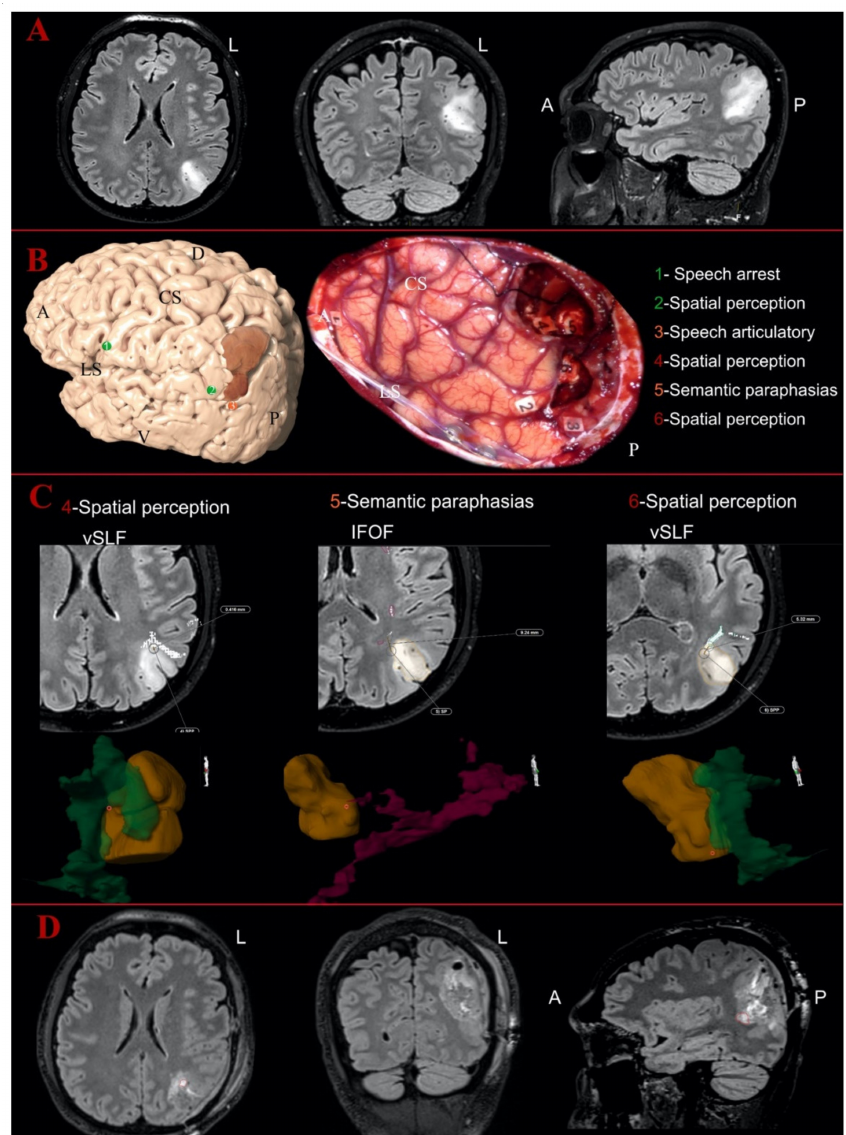
Figure 2. Illustrative case of parietal Oligodendroglioma Grade III on the left hemisphere: ( A ) the preoperative MR images of FLAIR sequences in axial, coronal and sagittal perspective; and ( B ) the 3D reconstruction of the left hemisphere with the tumor (in dark orange) and the distribution of the cortical eloquent spots in the upper part. The middle part shows the intraoperative picture after the mapping and the resection showing the distribution of the cortical and subcortical eloquent spots, listed in the lower part of the image. The spots are listed in green if considered outside the tumor area, in orange if peritumoral (<10 mm) or in red if considered intratumoral. ( C ) The postoperative analysis of the subcortical spots displayed in axial slices with the distance from the related white matter bundles and the 3D reconstruction of the points-tumor and white matter reconstructions. The vertical segment of superior longitudinal fasciculus is displayed in dark green, while the inferior fronto-occipital fasciculus (IFOF) is in magenta here. Number 4 and Number 6 were detected as intratumoral eloquent spots eliciting spatial perception disturbances, but they were not inside the vSLF reconstruction. Spot Number 5 (elicited sematic paraphasia) was detected as peritumoral and again not inside the course of the IFOF according to the 3D tractography reconstruction. ( D ) The postoperative images with FLAIR sequences in axial, coronal and sagittal perspective, showing in axial and sagittal a portion of the residual tumor in the ventral and anterior portion of the surgical cavity. A, anterior; D, dorsal; L, left; V, ventral; P, posterior; CS, central sulcus; LS, lateral